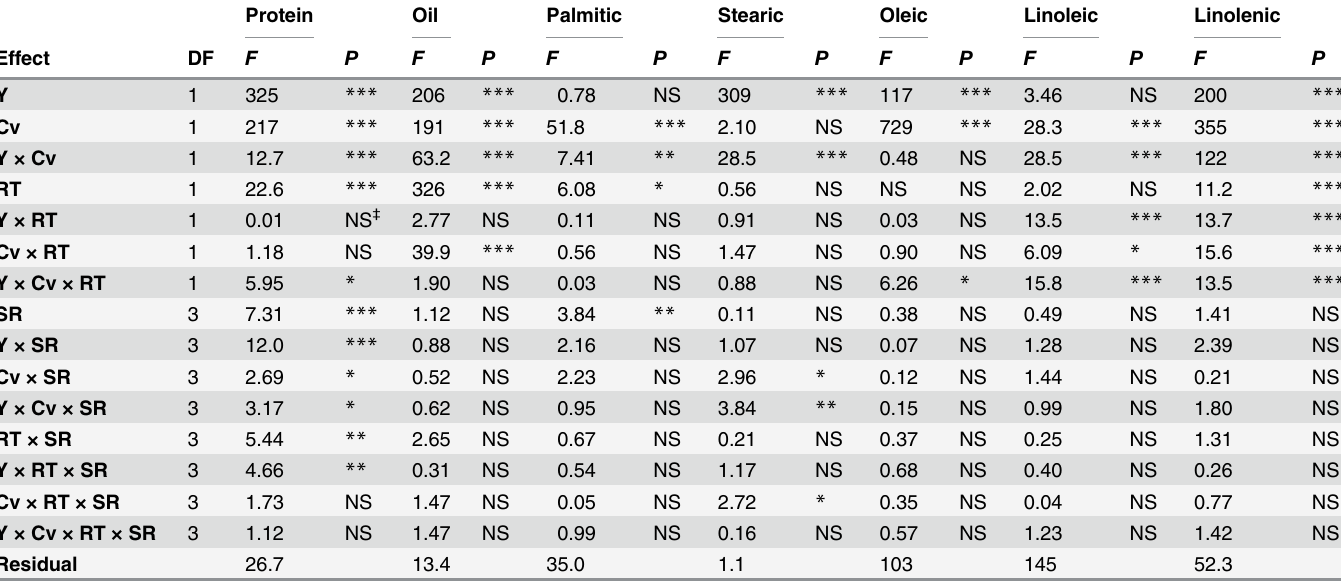
Table 1. Analysis of variance ( F and P values) of the effects of year (Y), cultivar (Cv), row-type (RT, either single- or twin-row), and seeding rate (SR) on the concentrations of seed protein, oil, and fatty acids (g kg -1 ) in soybean cultivars 94M80 and GP 533 in Sharkey clay soil. a Protein Oil Palmitic Stearic Oleic